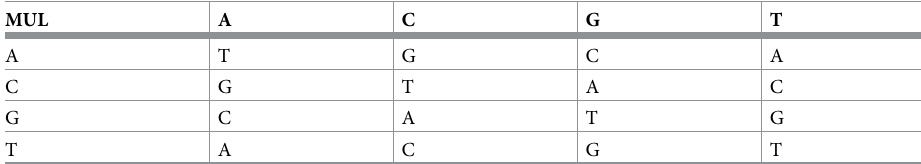
Table 7. DNA multiplication.